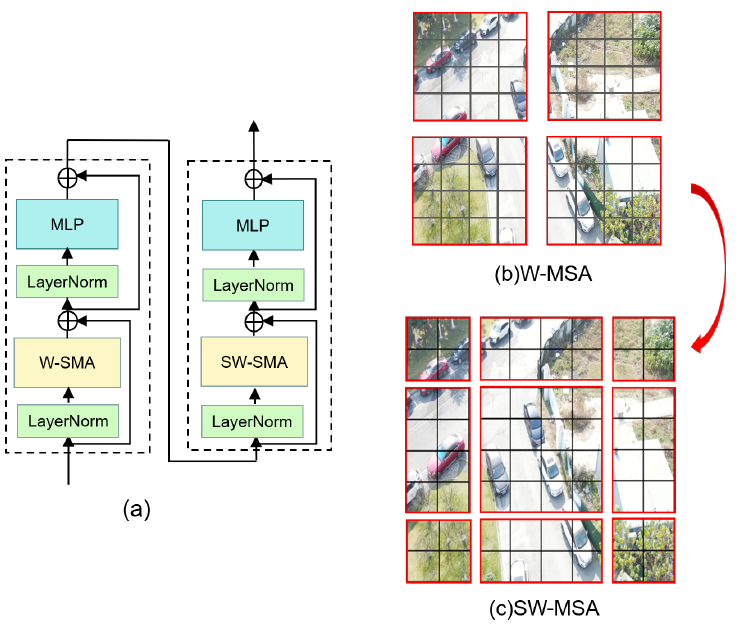
Figure 1. ( a ) Two consecutive Swin Transformer blocks; ( b , c ) is the description of the shift window method for calculating self-attention in the Swin Transformer